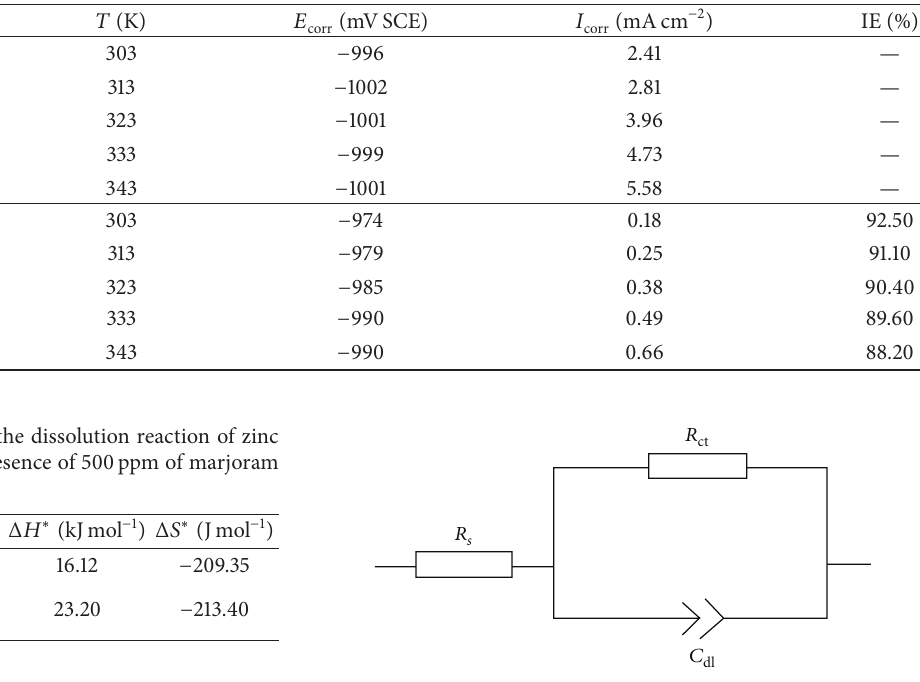
Figure 7: Electrical equivalent circuit ( 𝑅 𝑠 Ω = uncompensated = charge transfer resistance and 𝐶 solution resistance, 𝑅 ct layer capacitance).